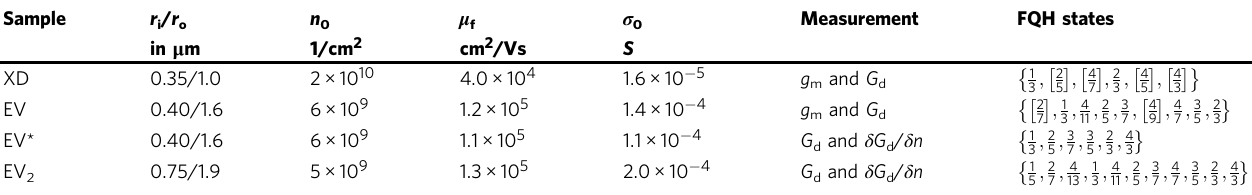
Inner and outer radii r i and r o , respectively, n 0 is the residual charge density, fi eld effect mobility μ f is measured at n (cid:3) 5 ´ 10 10 cm (cid:2) 2 , and σ 0 denotes the minimum conductivity; the contact resistance R c was subtracted off from the conductivity only when calculating μ f . The FQH states probed by g m are indicated by square brackets [ p / q ], otherwise the identi fi cation is based on differential